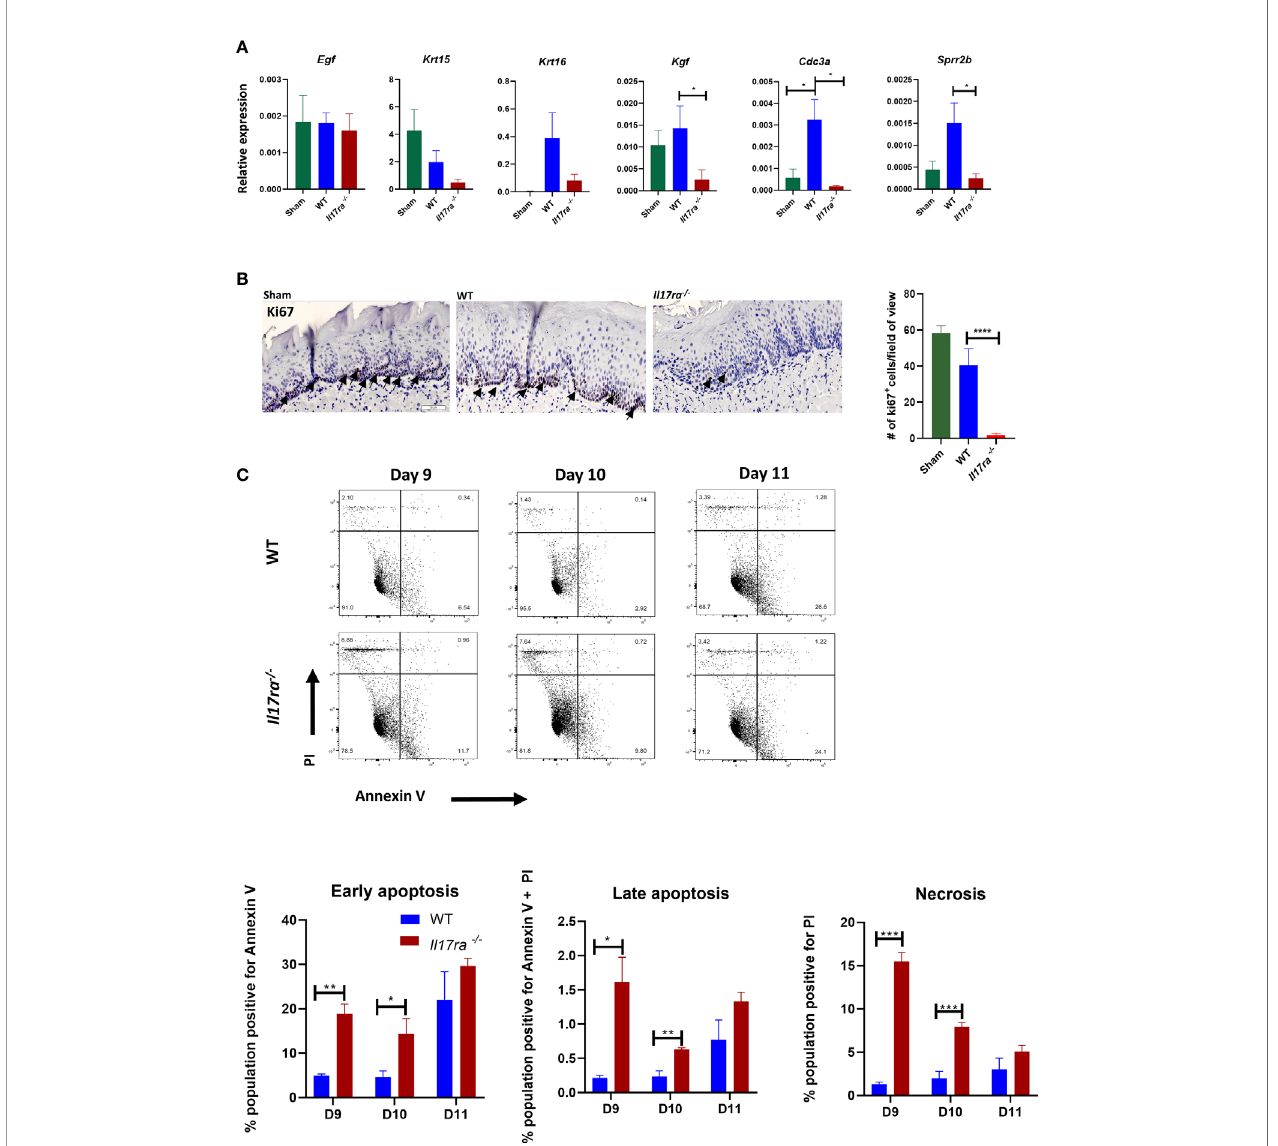
FIGURE 3 | In the absence of IL-17RA there is enhanced apoptosis and reduced proliferation (A) Expression differences relative to GAPDH of genes related to healing. N = at least fi ve mice/group. Kgf and Cdc3a analyzed by Kruskal – Wallace with Dunn ’ s multiple comparisons test, Sprr2b analyzed by ANOVA with Tukey ’ s. Data pooled from at least three experiments (B) Proliferation marker Ki-67 staining and quanti fi cation in the dorsal portion of the tongue obtained on day 11 following radiation. Scale bar, 100 µM. Arrows represent positive Ki67 staining. Analysis of staining by ANOVA with Tukey ’ s. (C) Apoptotic and necrotic cells analyzed by fl ow cytometric analysis after Annexin V and PI staining. Data representative of two independent experiments and analyzed by Student ’ s t test between days. Data shown as means ± SEM, (*P < 0.05, **P < 0.01, ***P < 0.001, ****P <